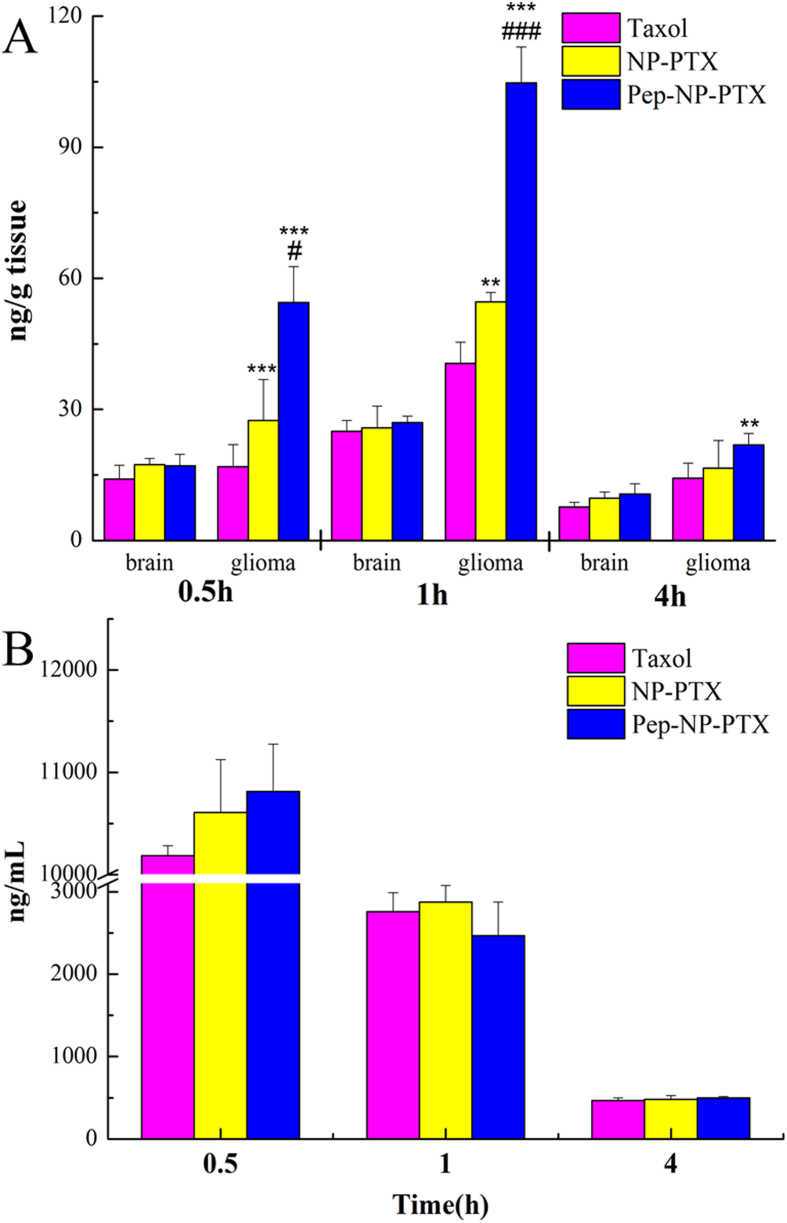
The PTX concentration of Taxol®, PTX-loaded NP and Pep-NP in brain and glioma (A), in plasma (B) at different times following i.v. administration to intracranial glioma-bearing ICR mice at a single 8 mg/kg dose of PTX (n = 5). **p < 0.01, ***p < 0.001 significantly higher than that of Taxol®, #p < 0.05, ###p < 0.001 significantly higher than that of NP-PTX.